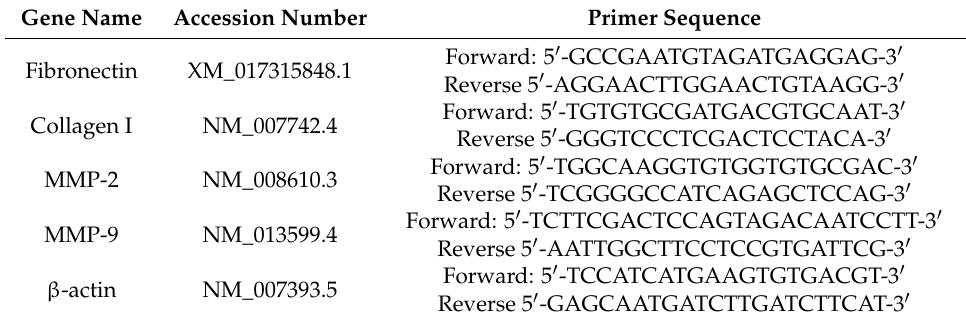
Table 1. Primer sequences used in real-time polymerase chain reaction (RT-PCR) analysis. MMP: matrix